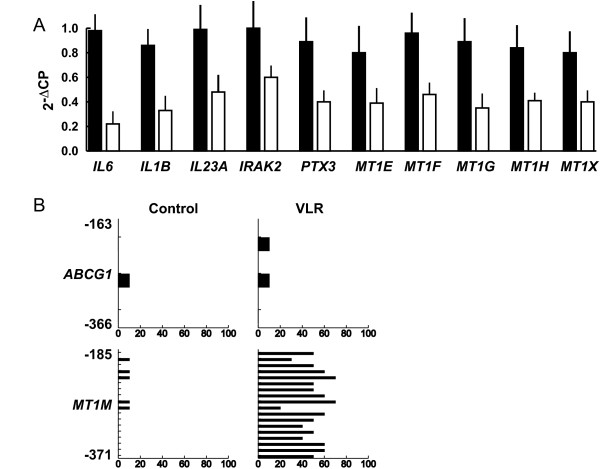
Methylation analysis of VLR-regulated genes. A and B, COBRA and bisulfite-modified DNA sequence analysis, respectively. A, values on the y-axis are 2-ΔCP in comparison with the average of mock digestion triplicates. An increase in methylation results in relatively low 2-ΔCP values. Black bars, control; white bars, VLR-stimulated. Bars, standard deviations. B, numbers on the vertical axis indicate the position of the analyzed sequence relative to the transcription start site (bp). Ticks represent CpG dinucleotides. Horizontal bars represent the extent of methylation of the corresponding residues in the clones analyzed.